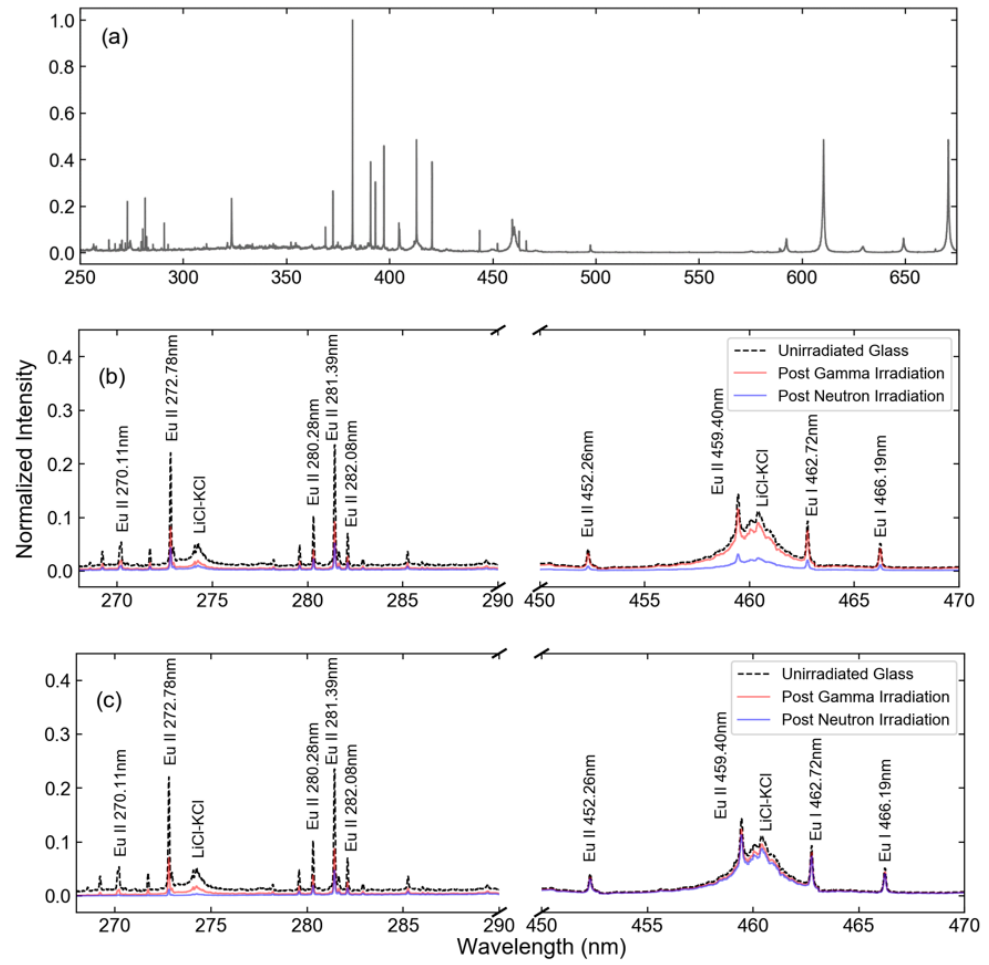
Figure 4. ( a ) Measured 1% Eu in LiCl-KCl spectra and the spectra adjusted for the expected changes in absorption in ( b ) Infrasil-302 and ( c ) sapphire windows in the ranges of 270–290 nm and 450–470 nm. Features resulting from the molten salt background are the result of many closely spaced atomic